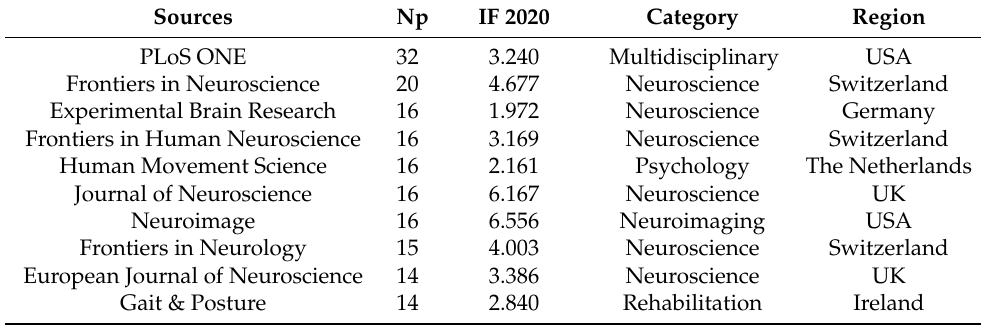
Table 1. The top 10 journals that published articles on rhythmic auditory stimulation research. Sources Note. Np = number of